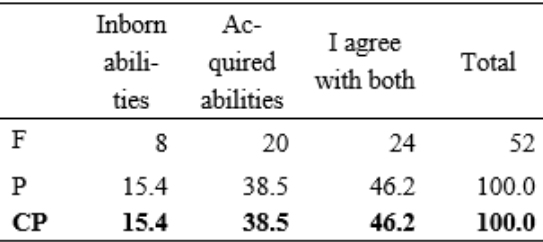
Table 1. Student’s attitudes about abili